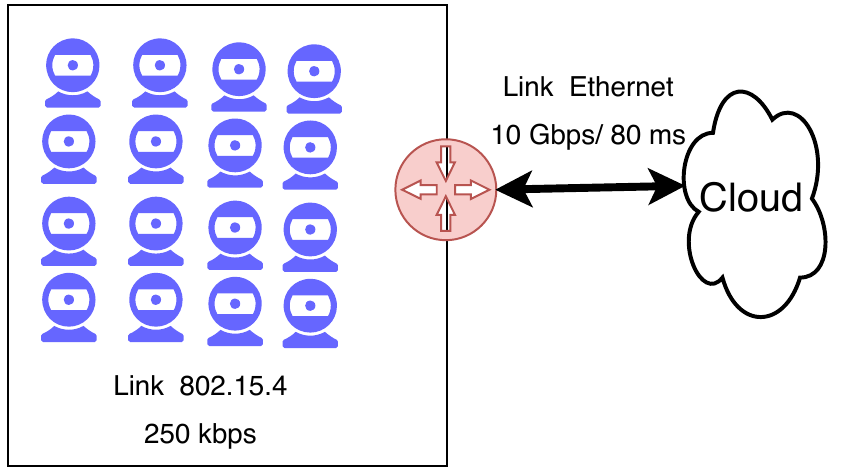
Figure 9. Scenario with 16 IoT devices.